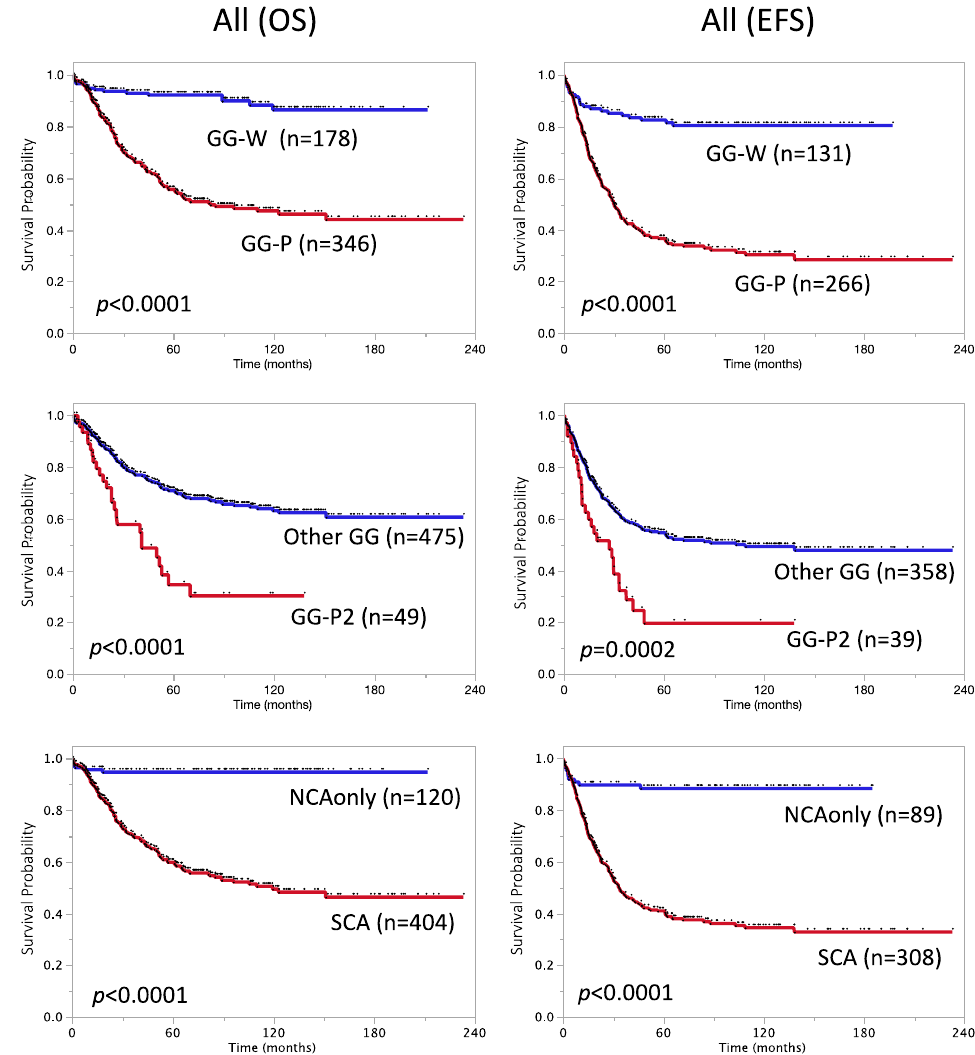
Figure 1. Kaplan–Meier survival curves of patients divided by genomic factors. OS ( left ) and EFS ( right ). OS: overall survival; EFS: event-free survival; GG: genome group; Other GG: GG-Wa, GG-Ws, GG-Pa (but no GG-P2a), or GG-Ps (but no GG-P2s); NCA: numerical chromosome aberration; SCA: segmental chromosome